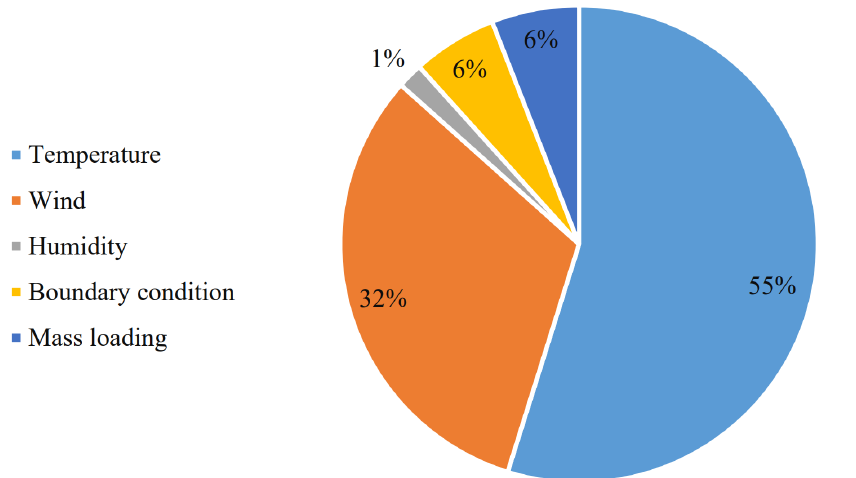
Figure 3. Breakdown of various EOCs studied for SHM.